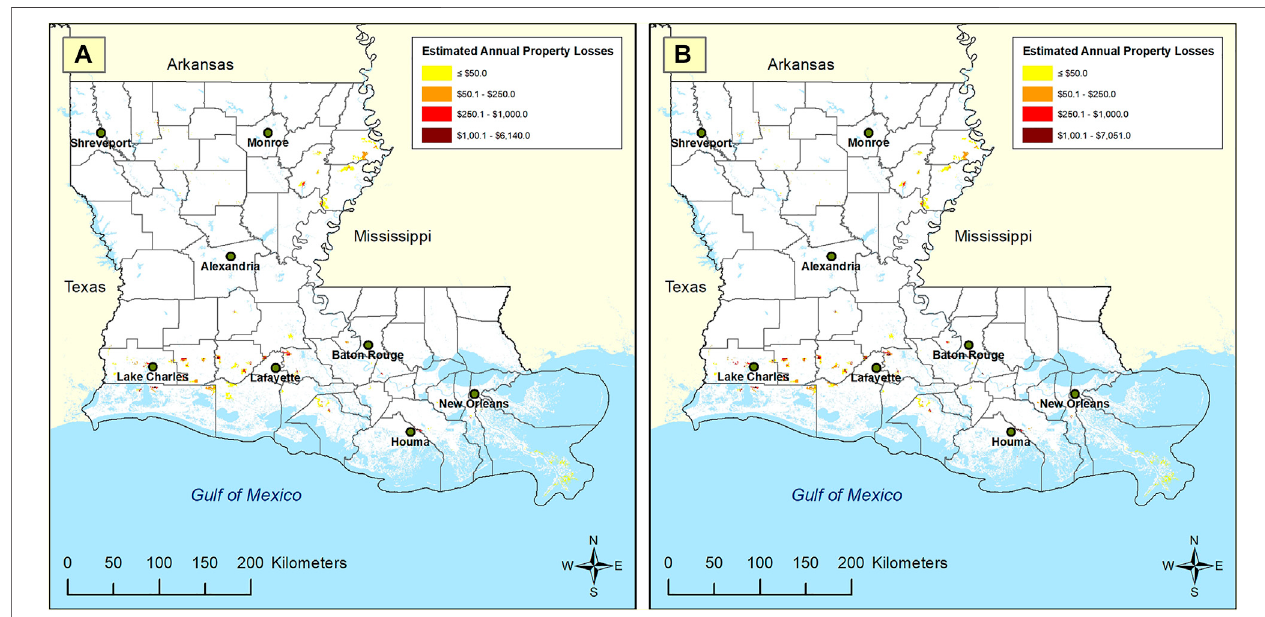
FIGURE 5 | Estimated annual property loss (2010$) due to sinkhole by census block: (A) historical (present), and (B) 2050.